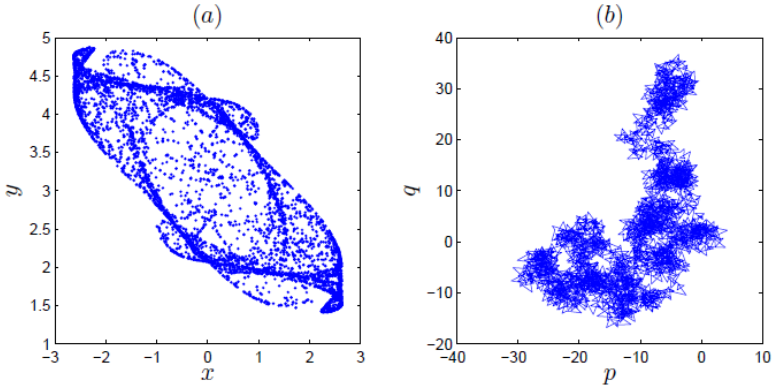
Figure 1. Chaos in the fractional memristive map for the fractional order α 1 = α 2 = 0.98 and system parameter a 1 = 2.6, a 2 = 1.1, and a 3 = 0.001. ( a ) Iterative plot, ( b ) 0–1